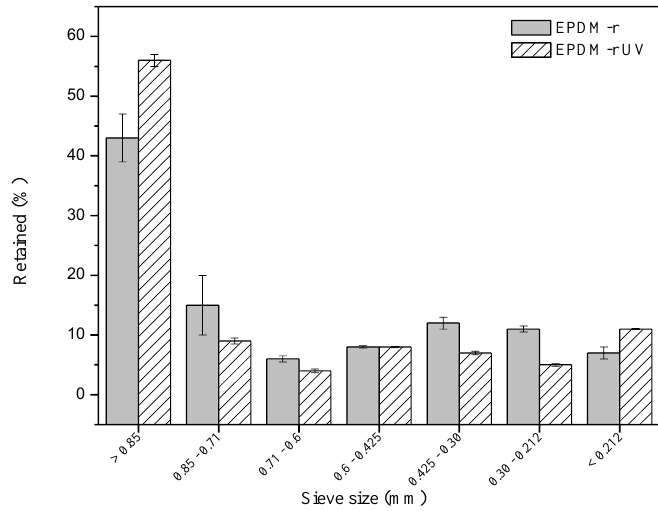
Figure 1. Particle size distribution of the EPDM-r and the EPDM-r UV.